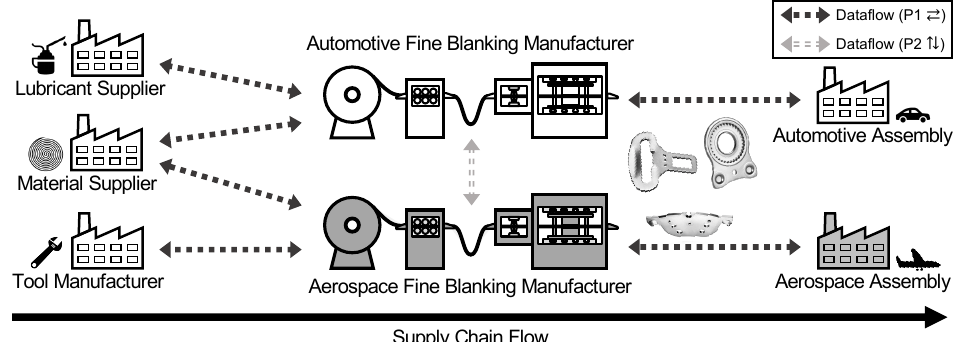
Figure 1. Manufacturing engulfs dataflows along the supply chain (P1 Õ ) and across supply chains (P2 Ö ). Suppliers (here: for lubricants, material, and tools) support manufacturers, who provide subsequent assembly lines with production data. Similarly, manufacturers exchange process information (here: fine blanking lines), the processed material, and their interplay. A currently lacking relationship between both assembling companies could stem from the untrusted environment (P3 We adapted the figure from our previous dataflow analysis in industry